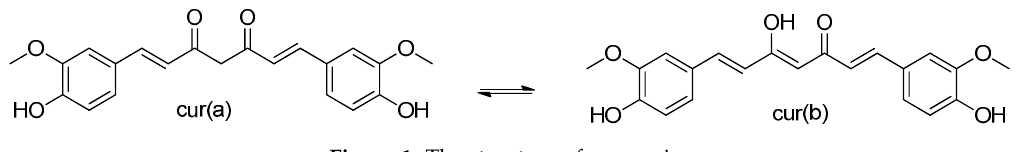
Figure 1. The structure of curcumin.